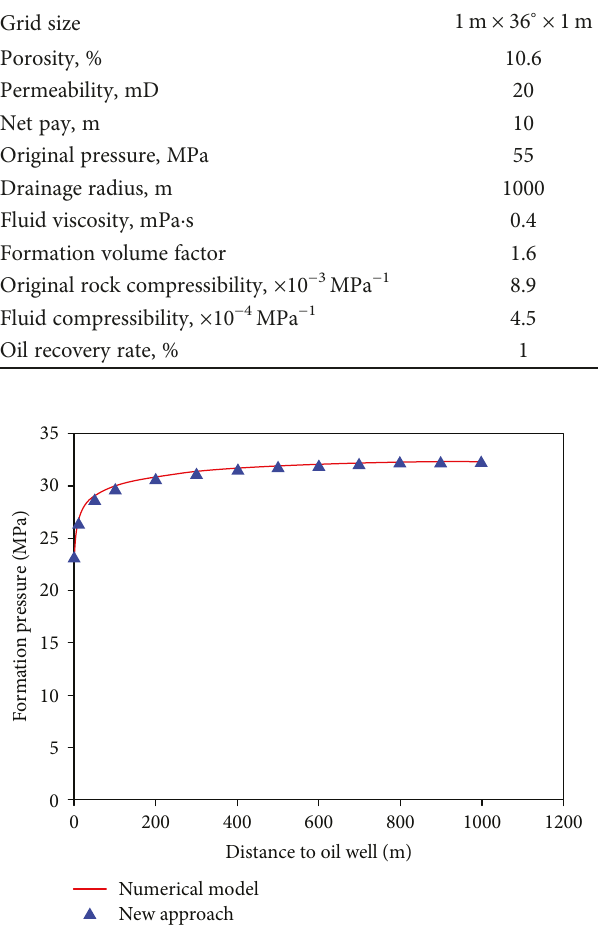
Figure 5: Veri fi cation of formation pressure distribution.